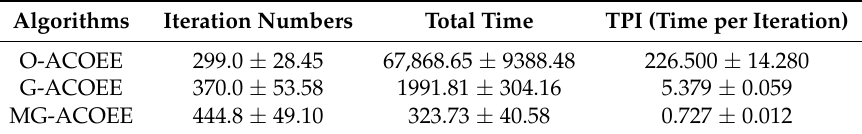
Table 7. Comparison of O-ACOEE, G-ACOEE, and MG-ACOEE (full constraint) on computing performance for Cuprite data.